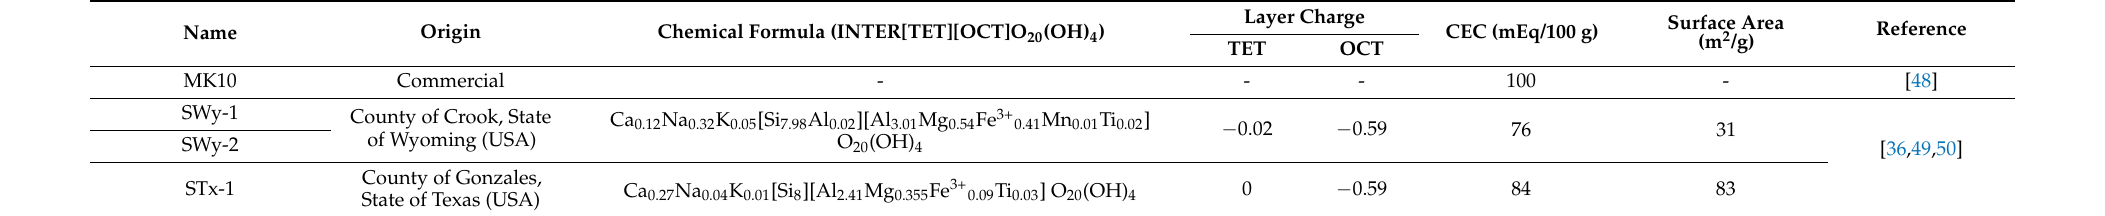
Table 2. Characteristics of commonly used montmorillonite clay